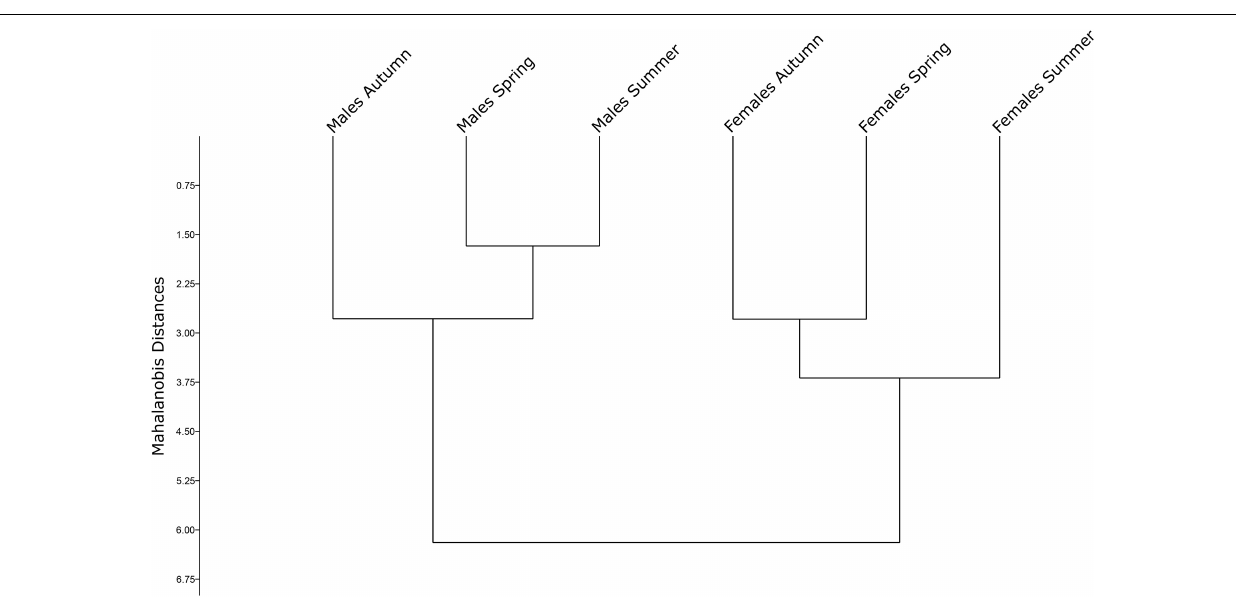
wings were narrower and lengthened, whereas females